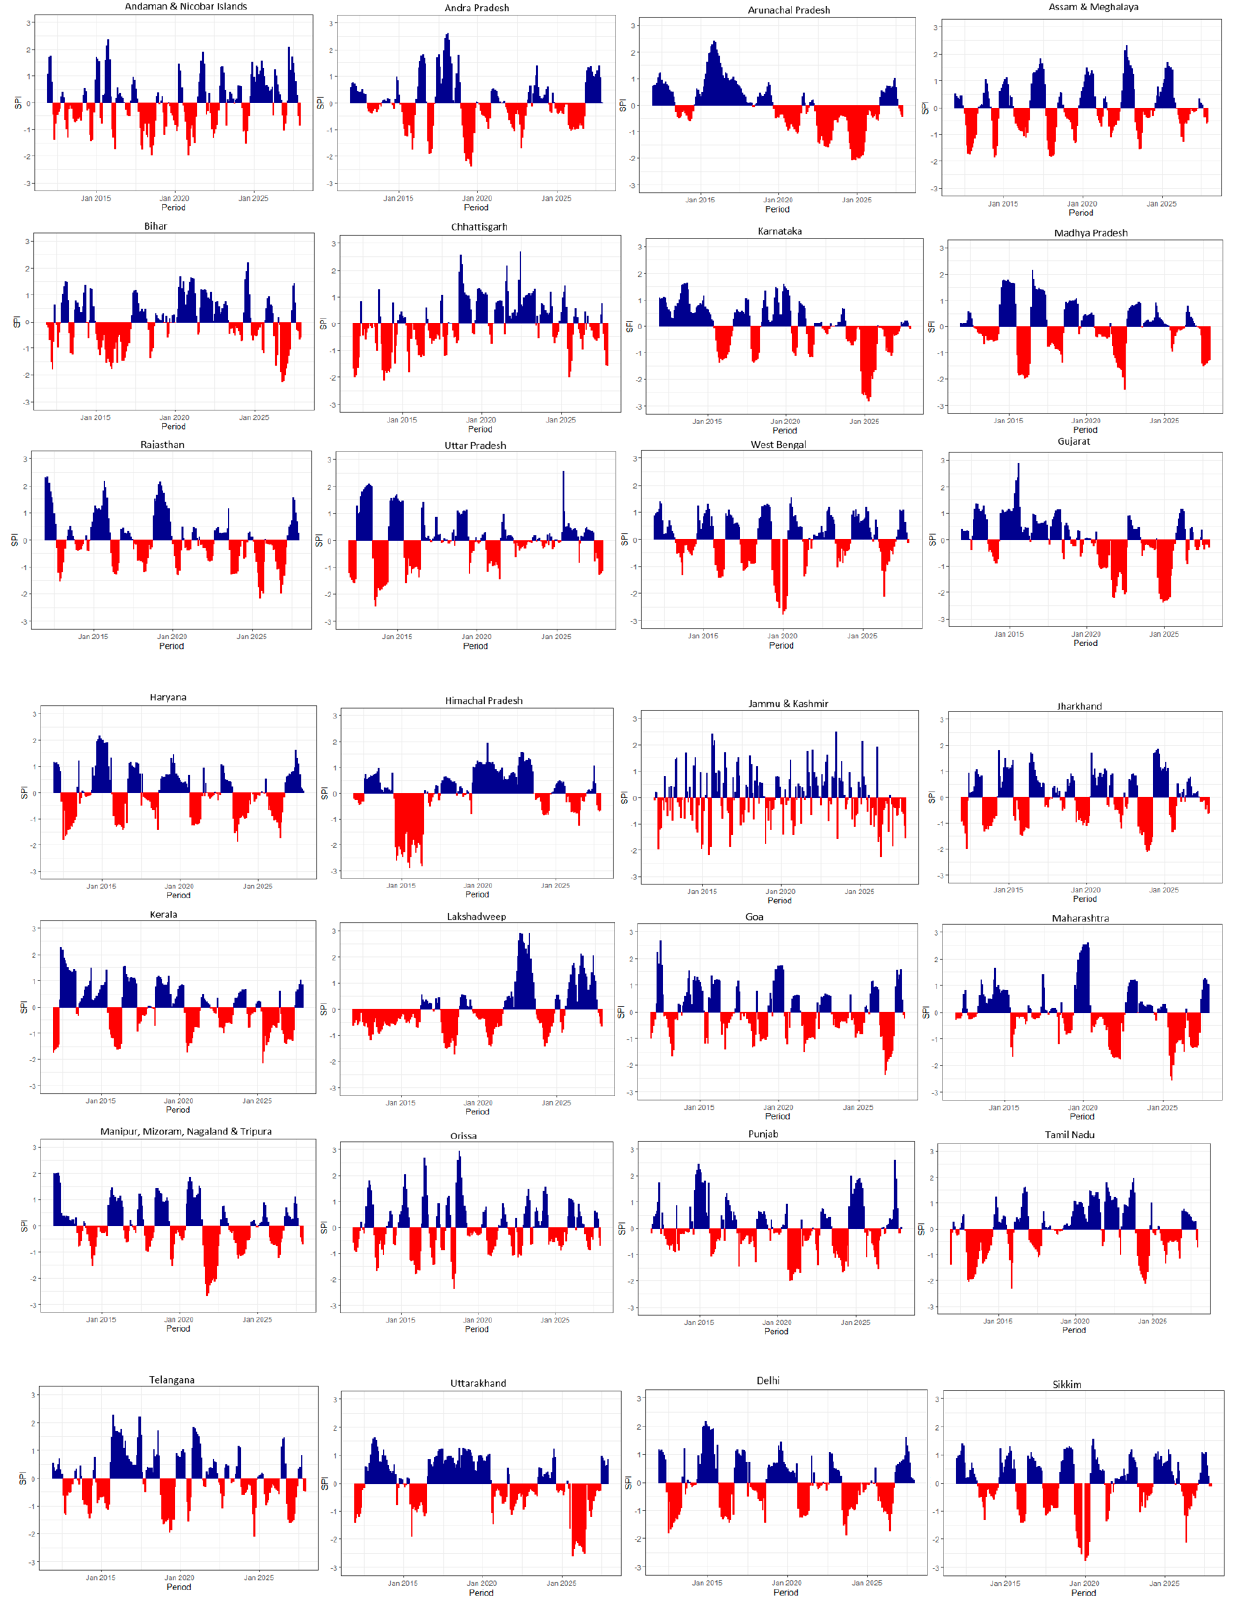
Figure 12. Drought index plotted from 2011 to 2027, estimated using the forecasted rainfall for various regions in India where x-axis specifies the forecasted period and y-axis is the SPI value.